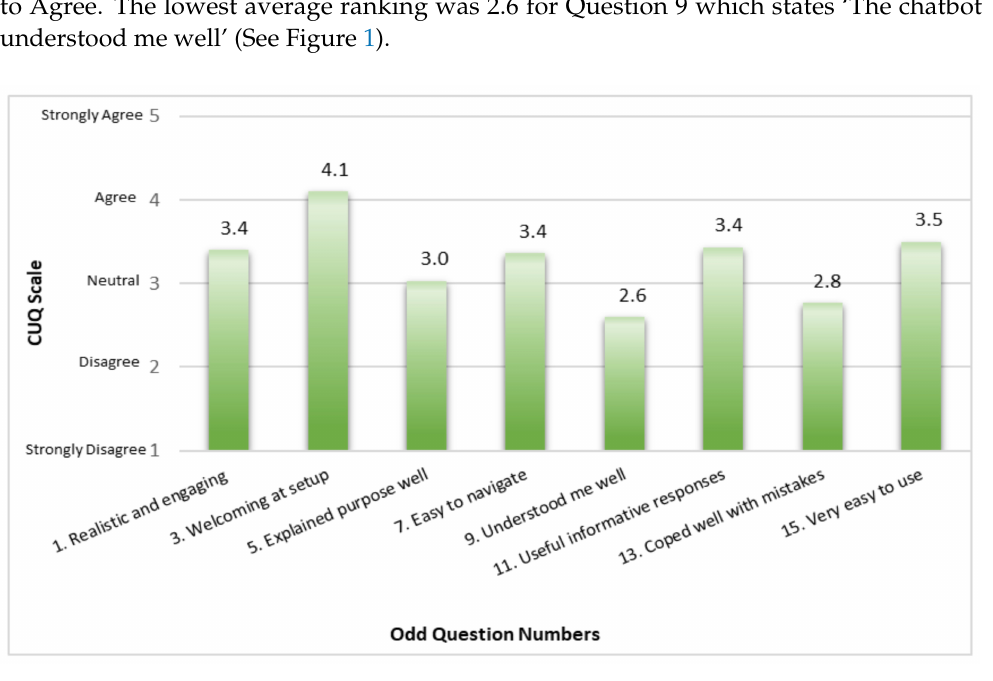
Figure 1. Average ranking for the positive aspects of MYA’s